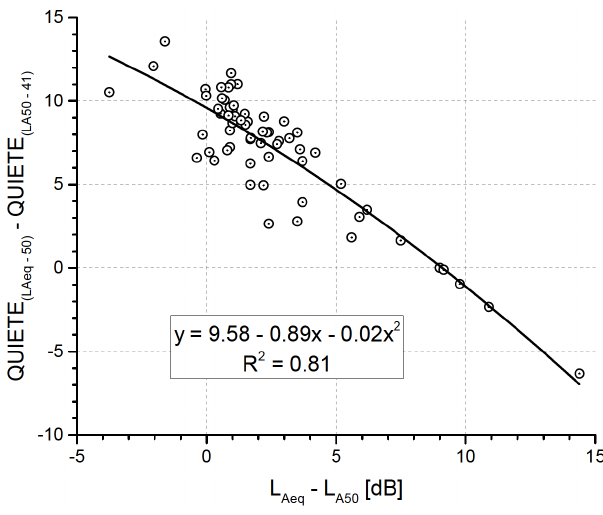
ThecalculationoftheQUIETEindexhasbeenalsoper-